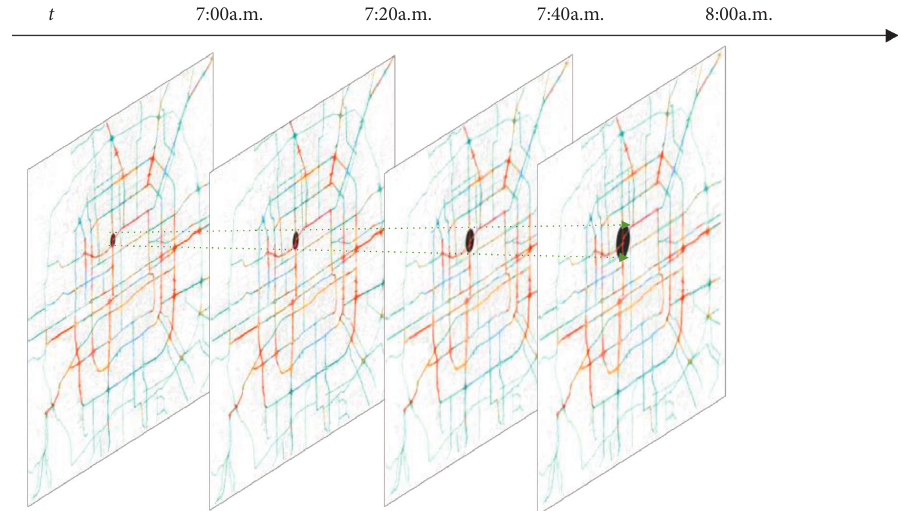
Figure 10: Three-dimensional congestion propagation